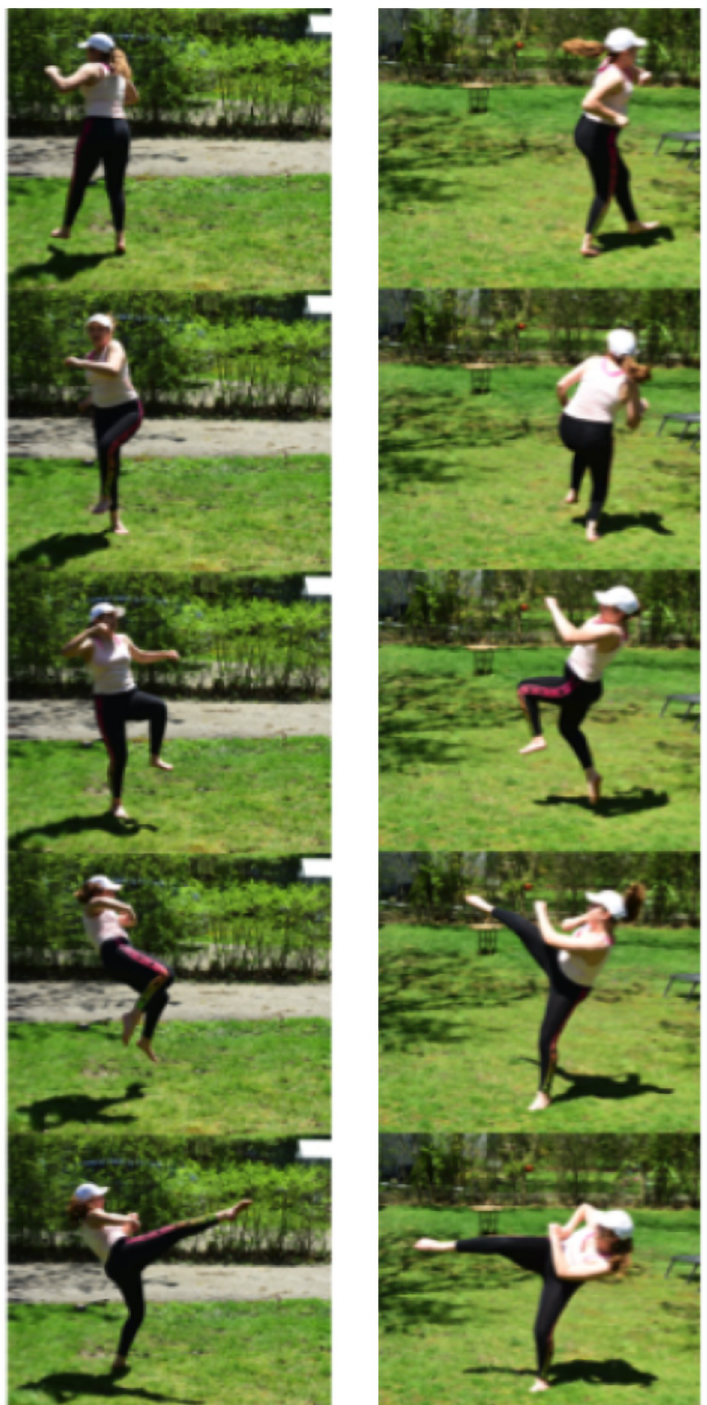
Fig 4. Nadabon kick. Two views of a nadabon kick, time proceeds downwards. Here, rotation is initiated by the left rear foot planted on the ground, and rotation of the lower body is accompanied by simultaneous rotation of the upper body. Kicking motion is created by jumping and bringing the rear foot